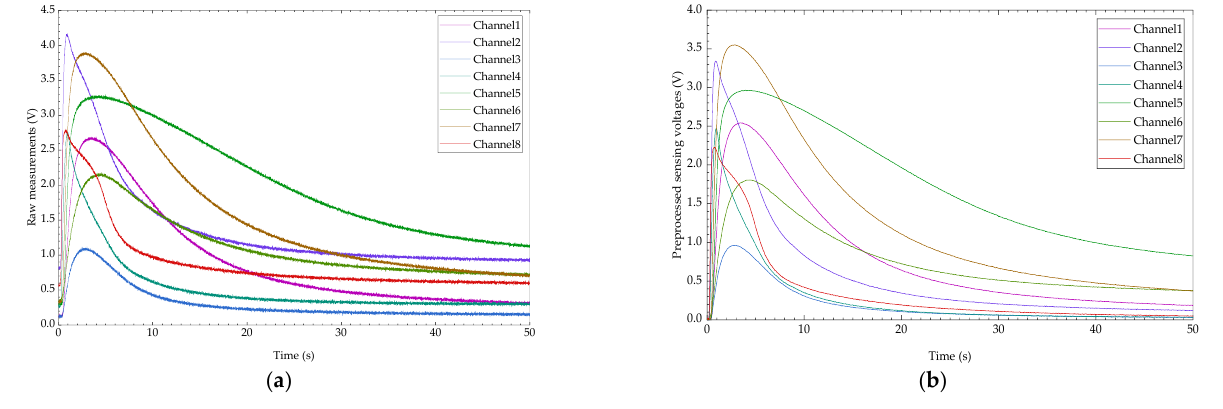
Figure 3. The raw and preprocessed measurements in a typical sampling cycle. ( a ) The raw sensing voltage measurements; ( b ) The preprocessed sensing voltage measurements.